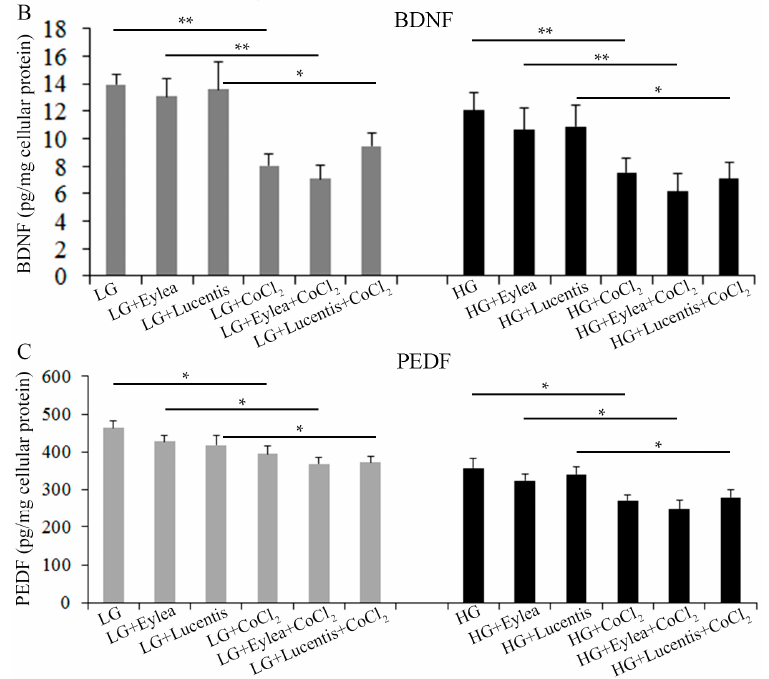
Figure 8. Aflibercept and ranibizumab did not affect the production of NT3, BDNF and PEDF in Müller cells. ( A ) Hypoxia significantly increased NT3 production compared with cells incubated in the medium containing LG or HG; ( B , C ) Hypoxia significantly reduced BDNF and PEDF and HG also significantly reduced PEDF production in ( C ). However, the addition of aflibercept and ranibizumab into media did not significantly affect the production of NT3, BDNF and PEDF in ( A – C ). * p < 0.05 and ** p < 0.01, n = 9/group in ( A ) and n = 6/group in ( B , C ). NT3, neurotrophin 3; BDNF, brain-derived neurotrophic factor; PEDF, pigment epithelium derived factor.